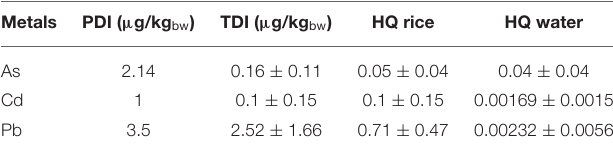
TABLE 4 | Permissible daily intake (PDI) of heavy metal(loids), TDI of rice, HQ of rice and water.